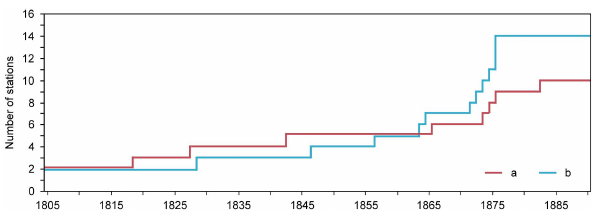
Fig. 8. Number of stations used for calculation of the mean Czech series in 1805–1900: (a) temperature, (b)